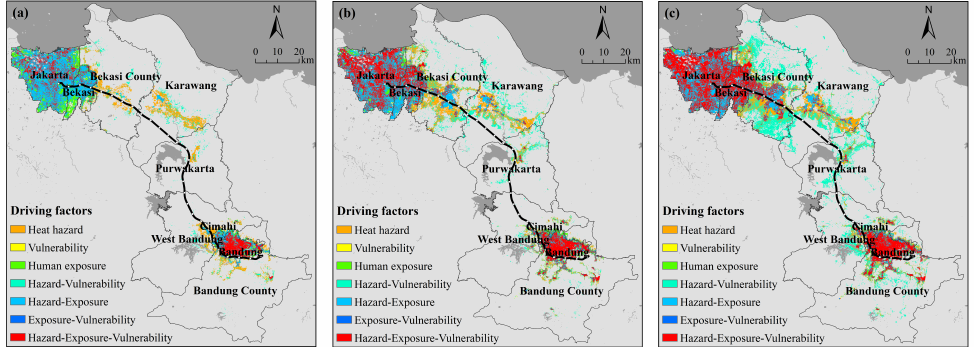
Figure 9. Leading factors of the heat wave risk (( a ) 2005, ( b ) 2014, ( c )